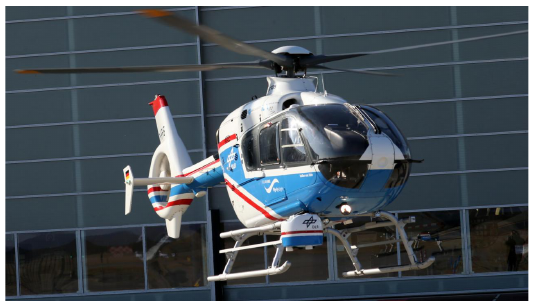
Figure 2. Helicopter EC 135 with 4K camera sensor